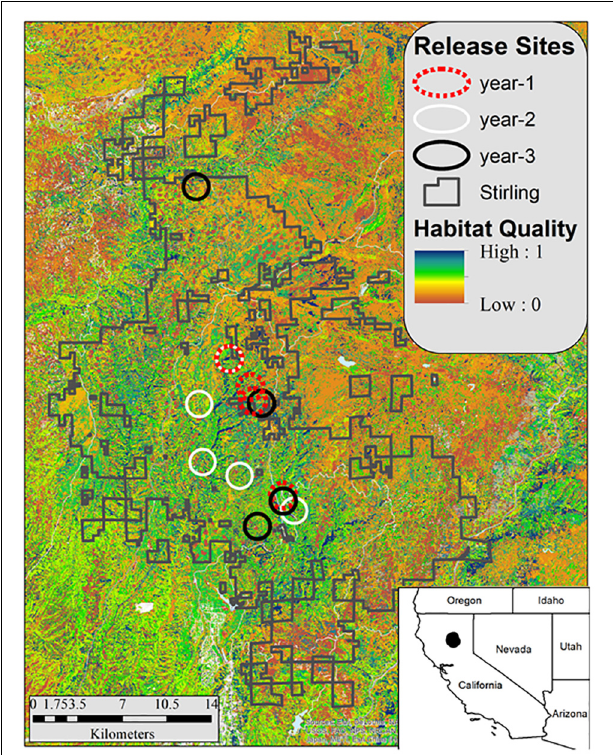
FIGURE 2 | Stirling Management Area in northern California (shown by the irregular blocks of land outlined by gray lines) and the fisher release areas by year (black circles = December 2009–February 2010, white circles = November 2010–January 2011, and red circles = October–December2011). The background shows habitat quality (blue is highest) estimated using the model of Thomasma et al.